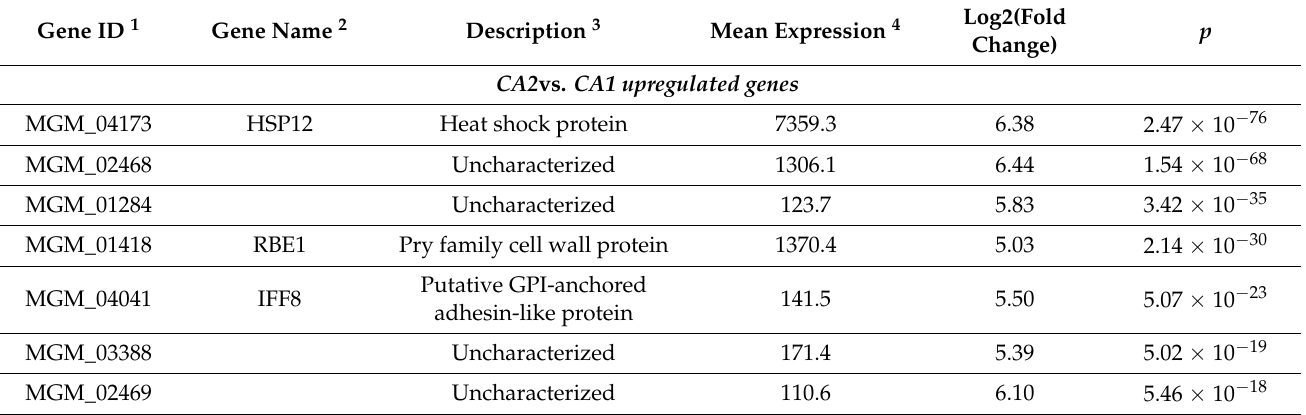
Figure 2. Hypsometric maps of the structure of 24 h and 72 h biofilm of Candida albicans isolates (CA1, CA2, CA3); nd—not determined. The CA3 isolate biofilm after 72 h was higher than the technical capacity of the confocal scanning laser microscope to produce a picture. Table 1. Differential expression characteristics of genes in Candida albicans isolates (CA1, CA2,